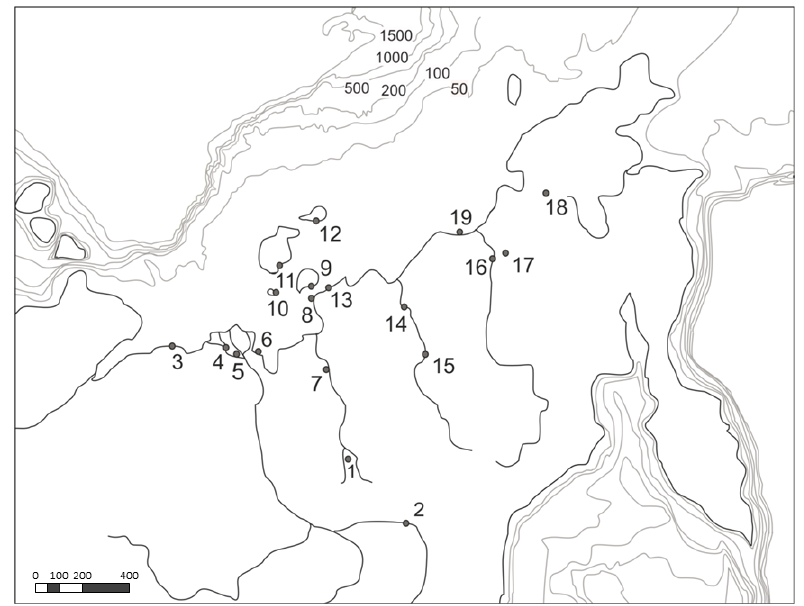
Figure 3. Overview map of the study region. Dots indicate sites mentioned in the text: 1 – Batagay outcrop, Yana Highlands; 2 – Mamontova Gora, Aldan River; 3 – Cape Mamotov Klyk, Laptev Sea; 4 – Diring Yuriakh Island, Lena Delta; 5 – Kurungnakh Island, Lena Delta; 6 – Bykovsky Peninsula, Laptev Sea; 7 – Mus-Khaya, Yana River; 8 – Cape Svyatoy Nos, Laptev Sea; 9 – Bol’shoy Lyakhovsky Island, New Siberian Archipelago; 10 – Stolbovoy Island, New Siberian Archipelago; 11 – Kotel’ny Island, New Siberian Archipelago; 12 – Island New Siberia, New Siberian Islands; 13 – Oyogos Yar, Dmitry Laptev Strait; 14 – Allaikha outcrop, Indigirka River; 15 – Sypnoy Yar, Indigirka River; 16 – Duvanny Yar, Kolyma River; 17 – Molotkovsky Kamen, Malyj Anjuy River; 18 – Lake El’gygytgyn; 19 – Chukochiy Yar, Chukochiy Cape. Combined and modified from Map of USSR, Main Bureau of Cartography and Geodesy, Moscow, 1958, pp. 3, 4, 8; the National Atlas of Russia, Volume 2, Main Bureau of Cartography and Geodesy, Moscow,